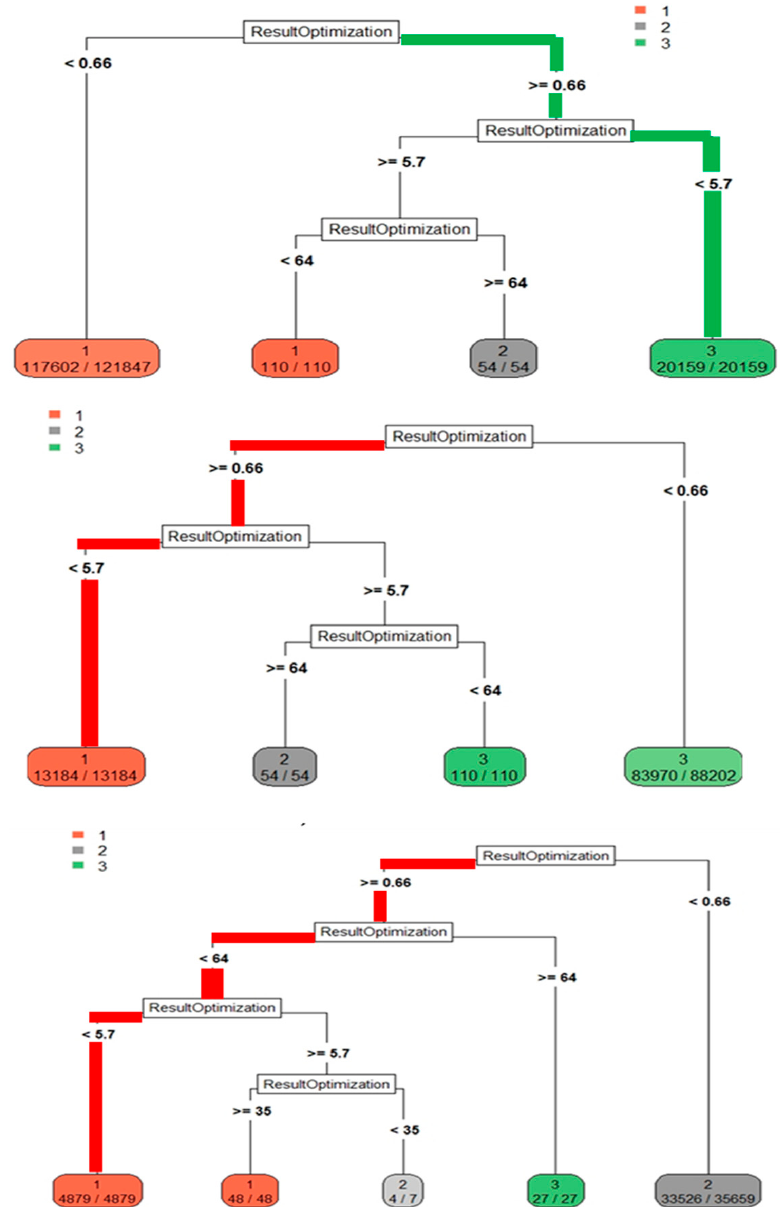
Figure 10. Decision tree. Results for Consumers 1, 2, and 4.